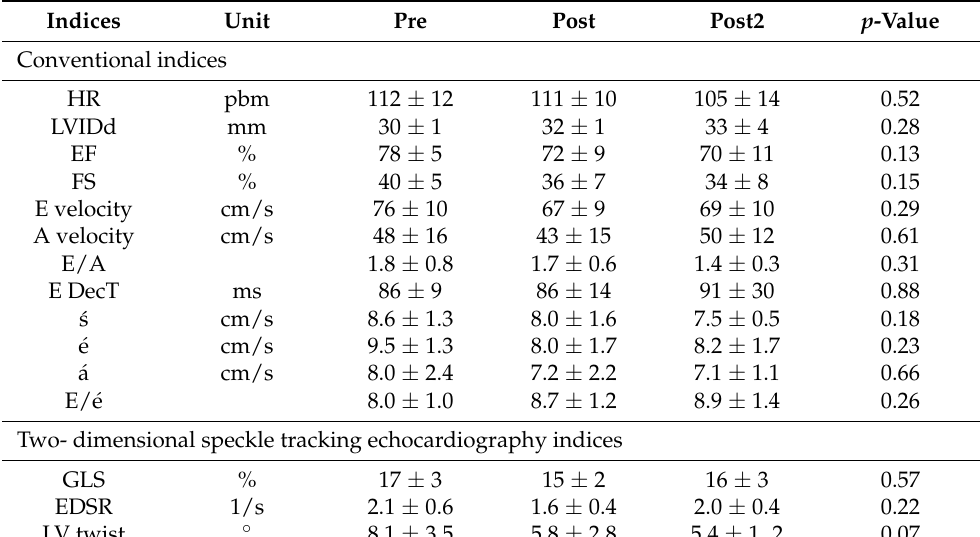
Table 2. Conventional and two-dimensional speckle tracking echocardiographic indices throughout the experimental time intervals during DXR-ICM in